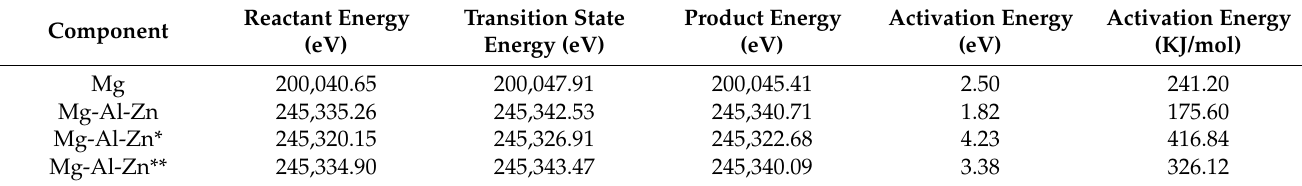
Table 4. Reactant energy, transition state, product energy, and activation energy for each Mg and Mg-Al-Zn component.